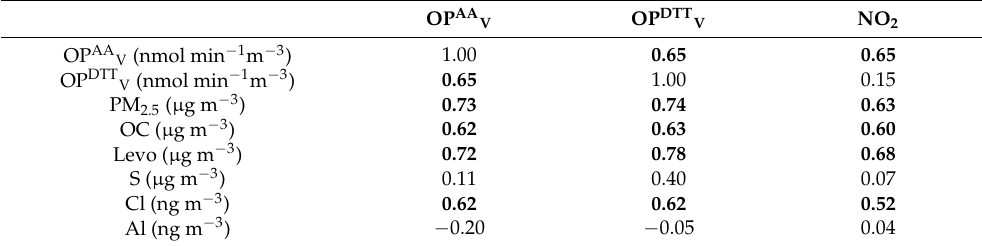
Table 2. Pearson’s correlation coefficients of the OP AA V and OP DTT V responses and air levels of NO 2 with the concentrations of PM 2.5 and PM 10 mass, PM 2.5 chemical components and air levels of NO 2 . Bold values indicate significant correlation at p < 0.01 level ( n =